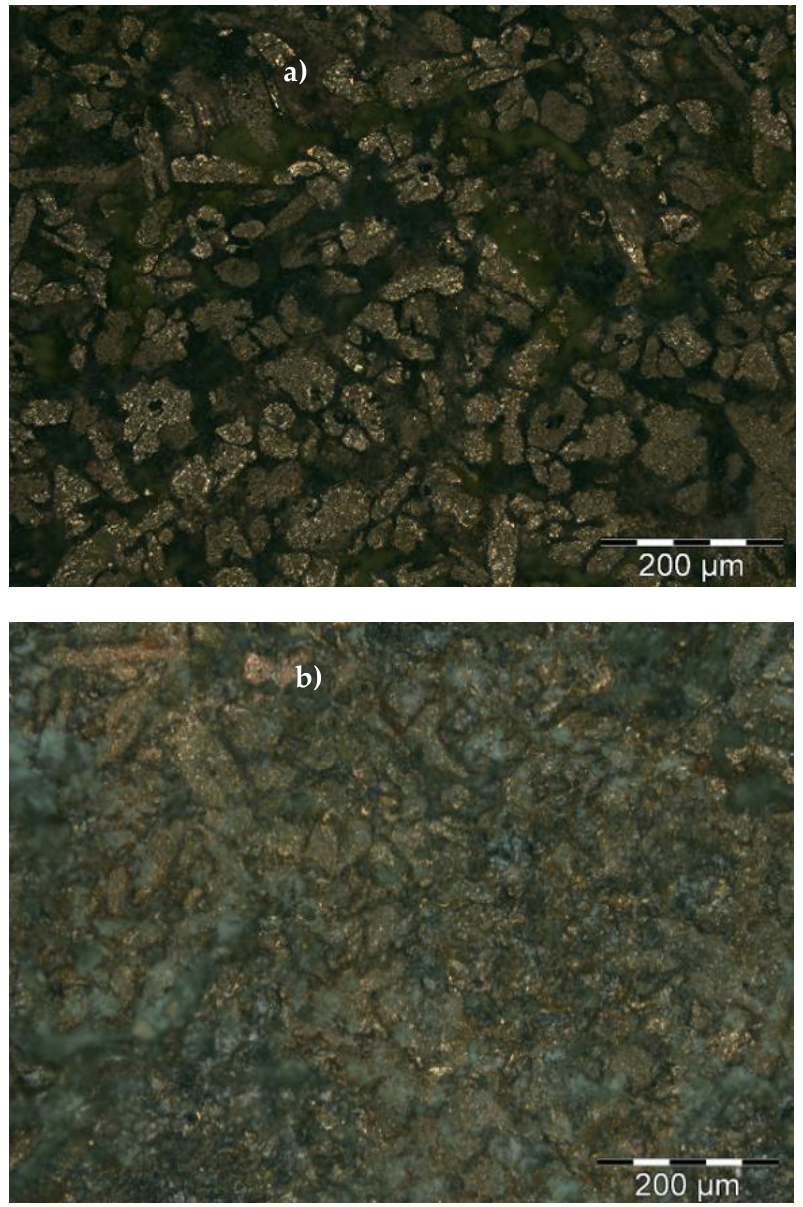
Figure 3. Surface aspect of the ( a ) “as-cast” samples and ( b ) annealed samples after the dealloying test. Table 2. Average depths of the corroded zones measured in the cross sections of samples B (as cast) and BR (annealed) after the dealloying